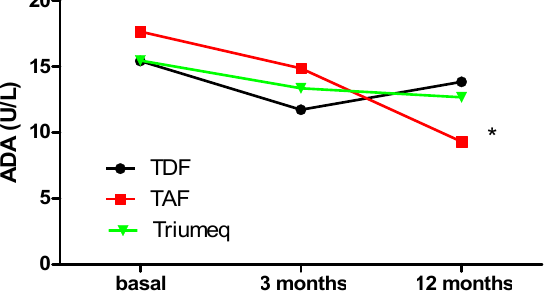
Figure 1. Evolution of adenosine deaminase (ADA) expression at 3 and 12 months after treatment initiation. The graph shows median ADA values in U / L for TDF, TAF and Triumeq. * p < 0.05 vs. baseline Table 1. ADA (U / L) plasma concentrations at baseline, 3- and 12-months post-treatment. It represented median (minimum value, maximum value). * p < 0.05 vs baseline.